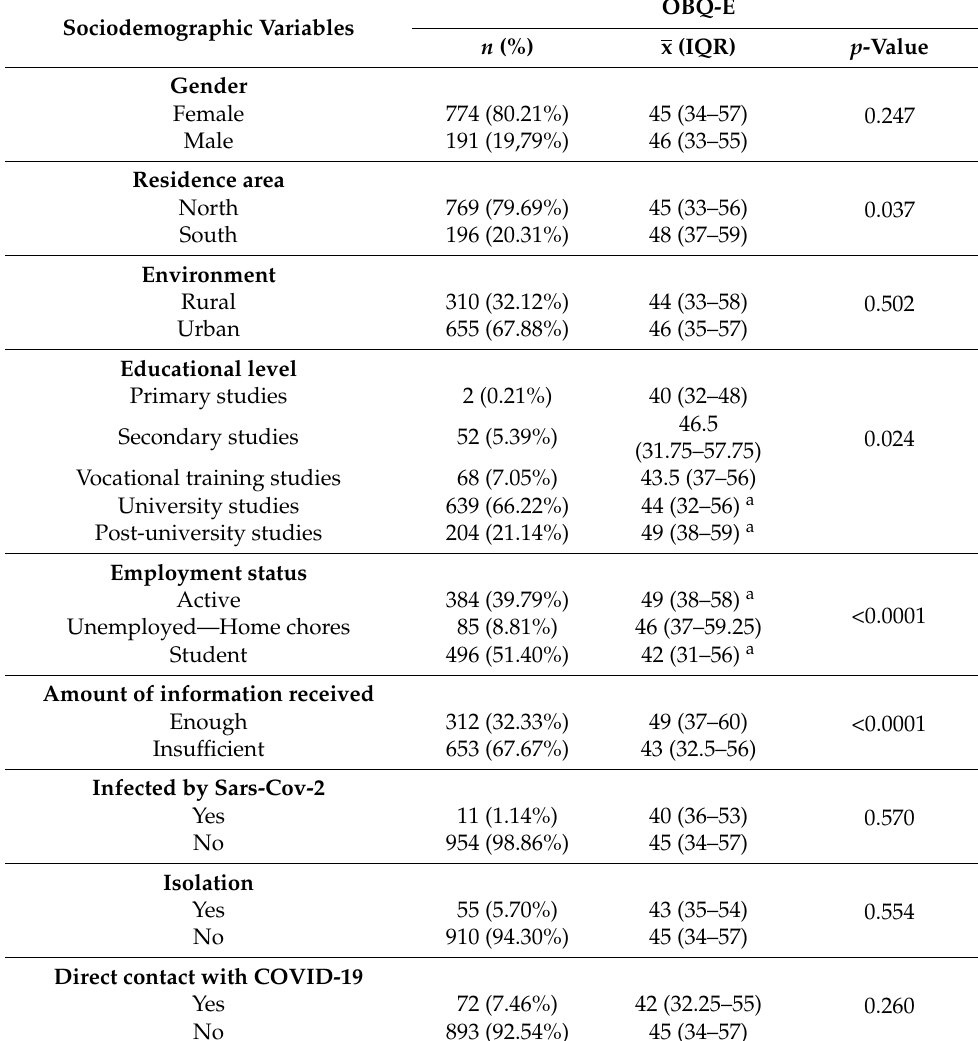
Table 1. Comparison of OBQ-E scores according to categorical